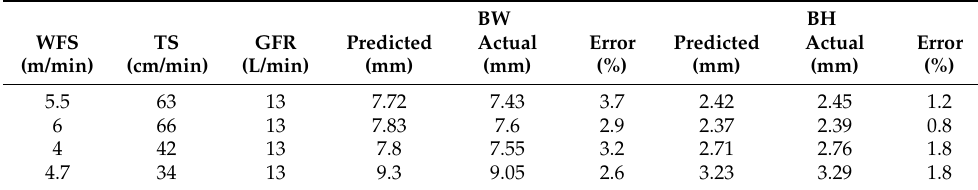
Table 7. The predicted and actual data corresponding to different input variables obtained using CMT—based WAAM